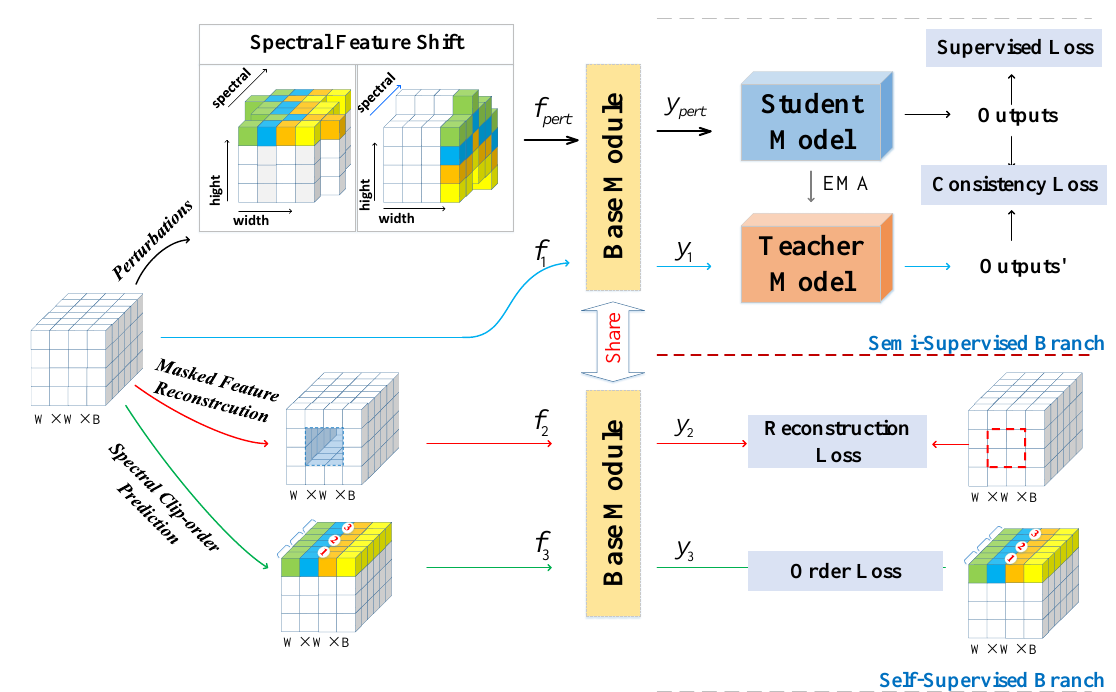
Figure 1. Overview of the proposed